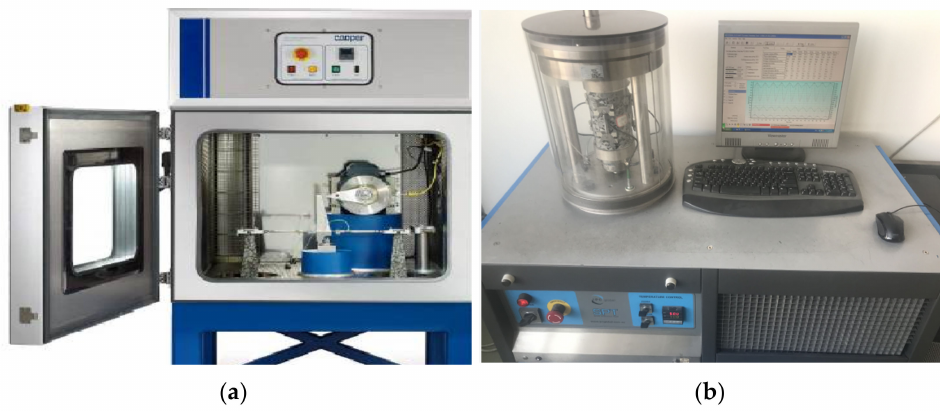
Figure 1. Schematic diagram of 2PT ( a ) and SPT ( b ) loading equipment.